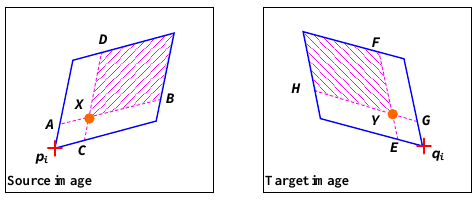
Figure 7. Matching expansion